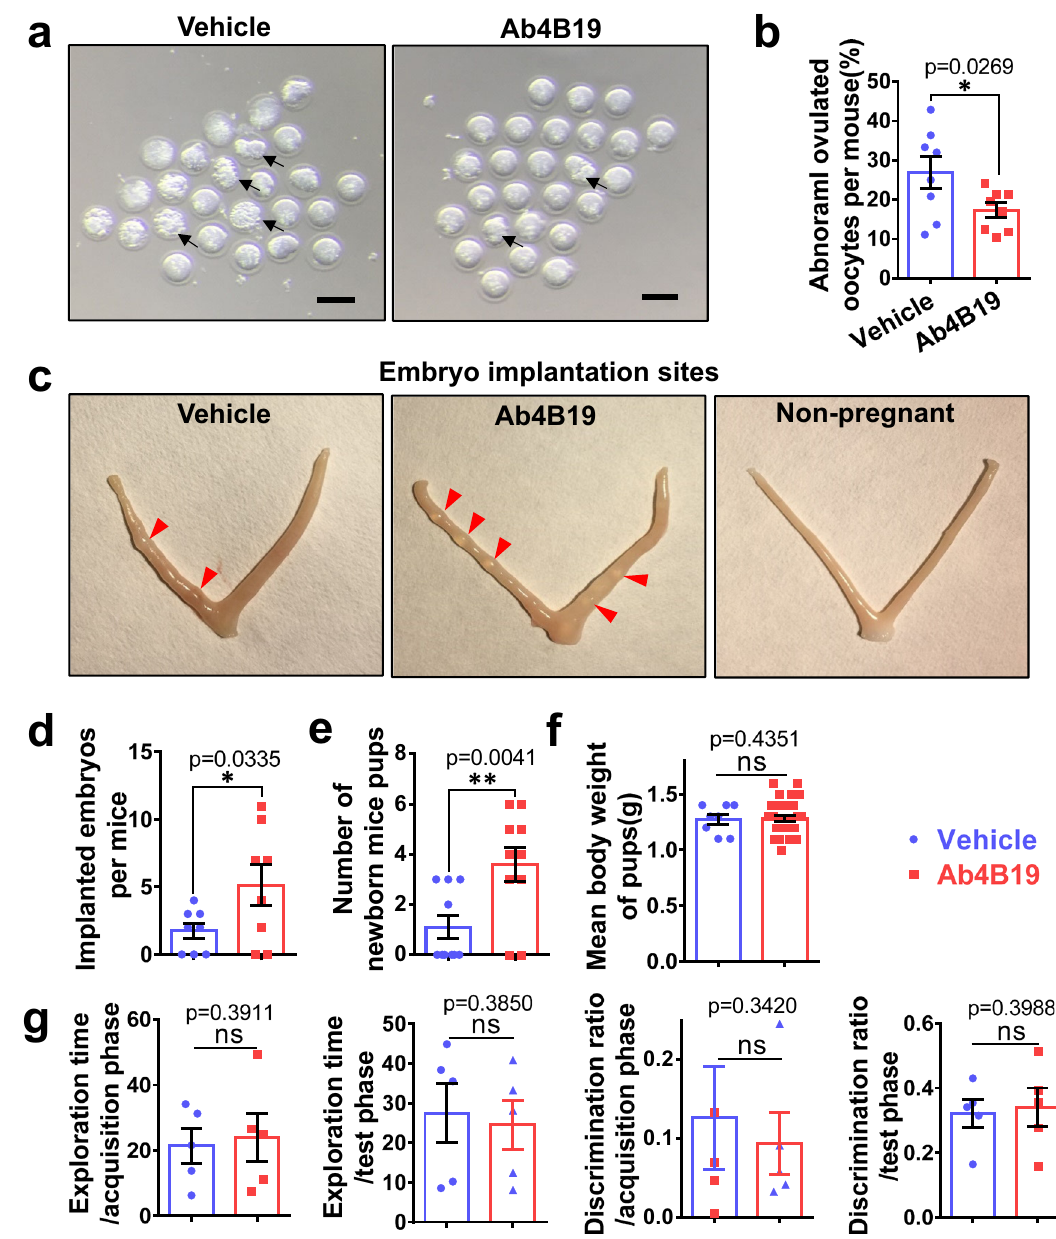
Fig. 4 Effect of Ab4B19 on fertility in NA-POF mice. a Representative photomicrographs of oocytes from NA-POF mice treated with or without Ab4B19. Note that there are much more abnormal oocytes in a vehicle-treated group than the Ab4B19-treated group. Black arrow: abnormal oocytes. Scale bar, 100 μ m. b Quanti fi cation of abnormal oocytes by the percentage of abnormal oocytes/total ovulated oocytes per mouse. N = 8 mice per group.